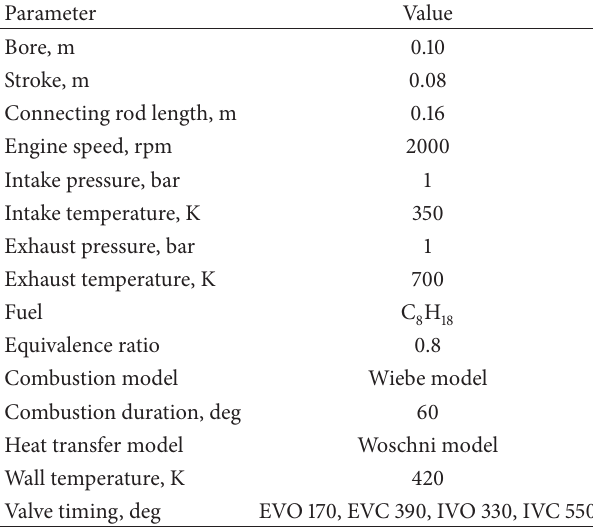
Table2:Geometryofengineandfixedengineoperatingparameters.